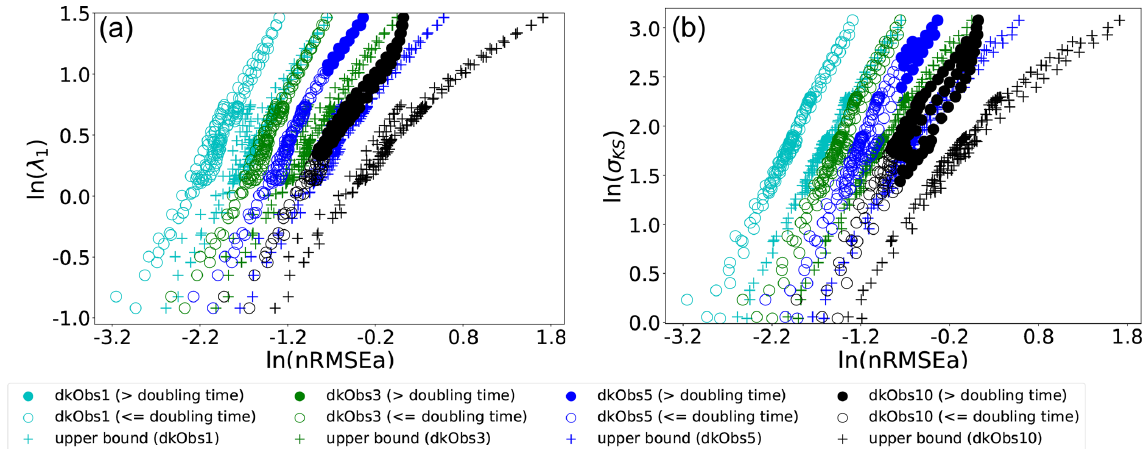
Figure 10. Scatter plots of σ KS (a) and λ 1 (b) against nRMSEa. The log–log scale is used on both axes. The different points refer to experiments with different observation intervals given in the legend and model parameters as in Figs. 3 and 5, excluding cases when σ KS < 1. The filled circle represents the cases where the observation interval exceeds the doubling time of the